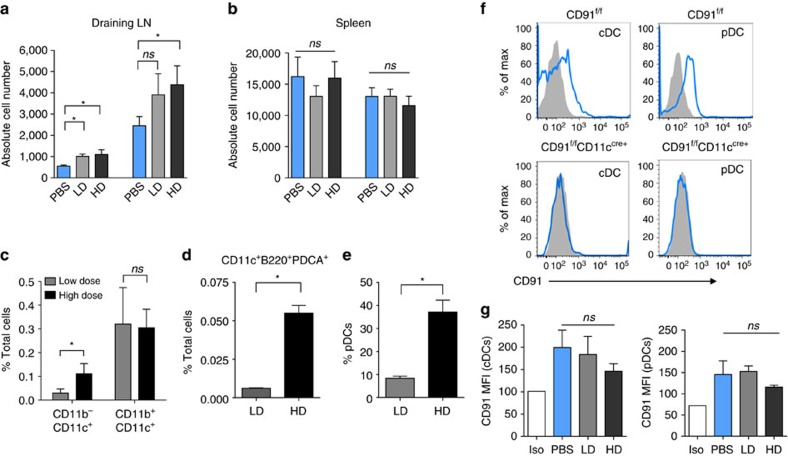
Preferential targeting of CD11c+ cells at high-dose gp96.(a,b) Mice were immunized intradermally with low-dose (LD) or high-dose (HD) gp96 or given PBS. After 18 h, draining lymph node (a) and spleens (b) were harvested and absolute numbers of CD11b+ and CD11c+ populations were analysed. n=5/group, data are from one representative experiment of three independent experiments performed. (c–e) Mice were immunized with low-dose (LD) or high-dose (HD) gp96A488. Lymph nodes were harvested 8 h later. Lymph node cells were analysed for A488 positivity by flow cytometry using CD11b and CD11c cell surface markers. Each population is shown as a percentage of the total lymph node cells (c). (d) The percent of pDCs in the CD11b−CD11c+ population from (c) that are A488+ is shown as a fraction of total lymph node cells. (e) The percent of pDCs that are A488+ is shown. Data are from one representative experiment of three independent experiments. (f) Histograms depict CD91 staining within representative lymph node cDC (CD11b+CD11c+) or pDC (CD11clow/+CD11b− B220+PDCA1+) populations from naive CD91f/f or CD91f/fCD11ccre mice. (g) Mice were immunized with low-dose (LD) or high-dose (HD) gp96 or given PBS. At 18 h post-immunization, lymph nodes were harvested and stained for CD91 in pDCs and cDCs. Shown are CD91 MFI values for each population. n=5/group, data are from one representative experiment of three independent experiments. Data are represented as mean±s.d. ns, not significant, *P<0.05 (Student's t-test used in c,d,e; one-way ANOVA used in a,b,g).